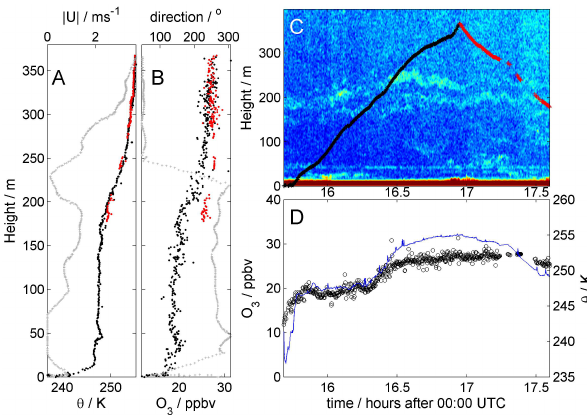
Fig. 6. As for Fig. 3, but for the first flight on 2 September 2007. Please note the difference in